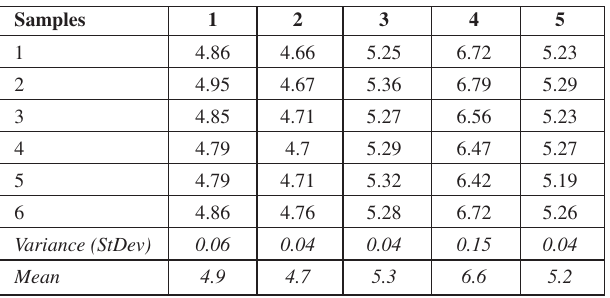
Table 2. The measurement of anthocyanin content in 6 randomly selected sour cherry varieties with five replications by portable UVEX ML-1 (Újfehértó, 2009) Samples